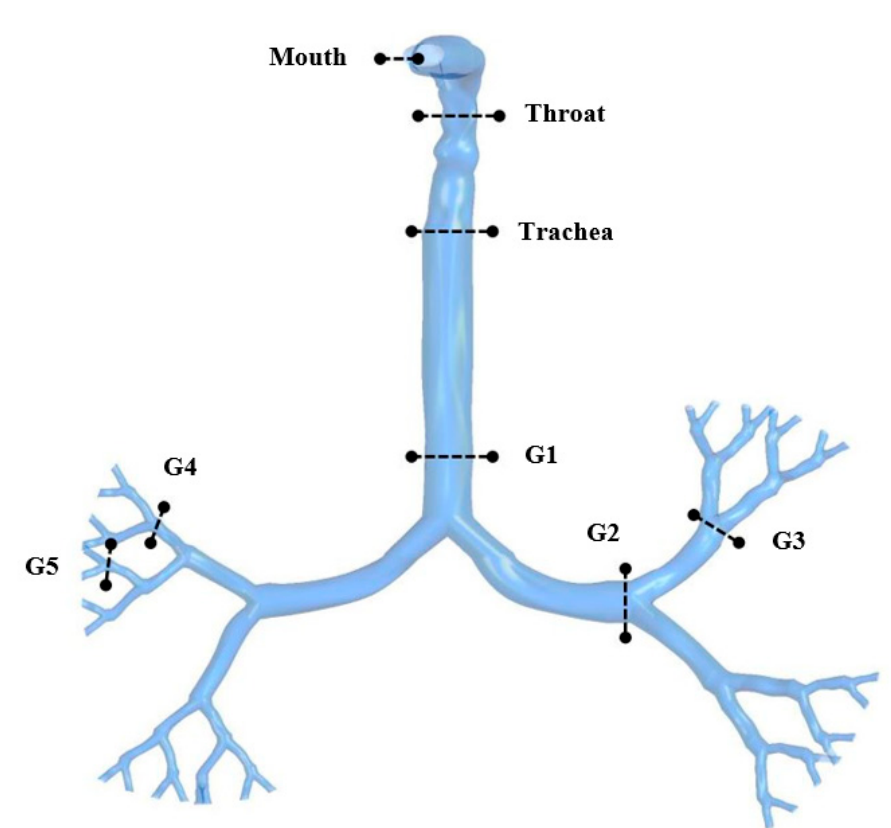
Figure 4. Selected planes for velocity contours at selected positions of the upper airways. To study the airflow patterns in the oral area, velocity profiles were calculated at selected positions of the mouth-throat and trachea areas. Figure 6 shows the velocity profiles at three selected cross-sections for the three different lung sizes and four different flow rates. Figure 6a shows the selected cross-sections of the airways in the oral area. Figure 6b–d show the velocity profiles in a 50-year-old lung, whereas Figure 6e–j show the velocity profiles for the 60- and 70-year-old lung. It can be seen in Figure 6 that the velocity profiles for each cross-section followed similar patterns in all three lung sizes. The throat area (Line 2) was found to have the highest velocity, while the lowest velocity was found at the trachea (Line 3) in all three cases. When comparing velocity patterns at the various flow rates, all flow rates generated similar velocity patterns for each area. It happened for all three lung cases. The highest velocities were found at 60 L/min at the throat cross-sections (Figure 6c,f,i) of all lung size cases. Velocities fluctuated most for the condition of 60 L/min flow rate at the trachea cross-section when compared to all other conditions. It is obvious that the throat area can experience higher velocities than other airway